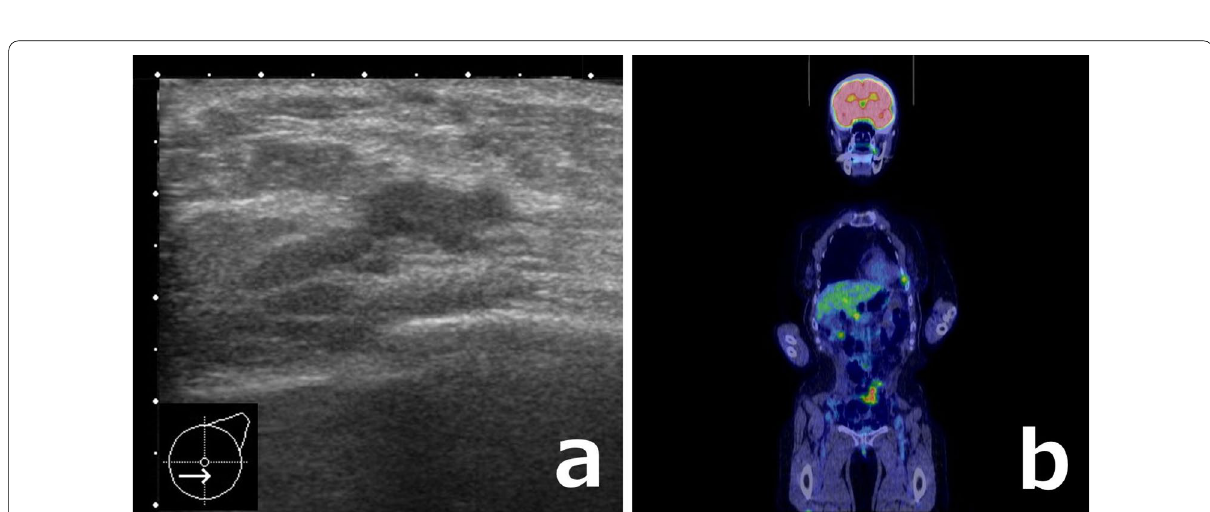
Fig. 5 Case 2: imaging findings. a Ultrasound revealed a low-echo area of 18 of the left breast. b Positron emission tomography–computed tomography showed abnormal accumulation in the rectal excision, peritoneal thickening in the pelvis, and other nodules in the abdominal cavity